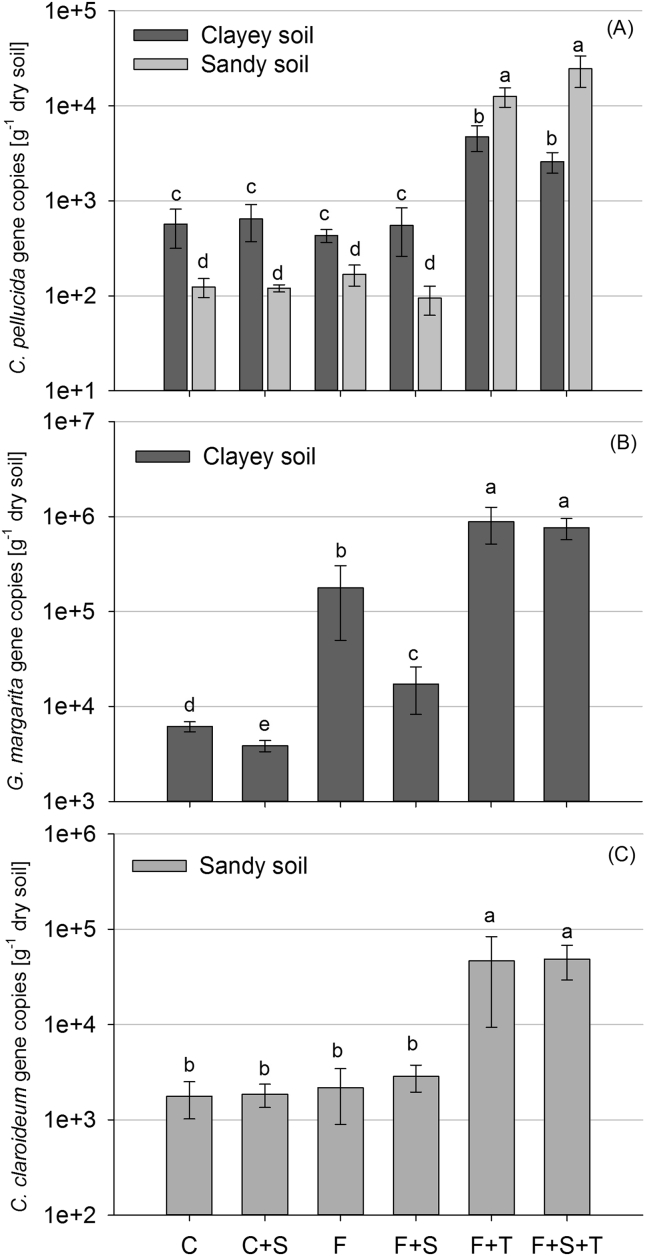
AMF taxa abundance at 42 DAI in the two soils (‘clayey’ (Humic Nitisol), ‘sandy’ (Ferric Alisol)). Different letters indicate significant differences at P < 0.05 and error bars represent standard error. Treatment codes are: uncoated maize (C), uncoated maize with S. hermonthica (C + S), coated maize with ‘Foxy-2’ (F), coated maize with ‘Foxy-2’ and S. hermonthica (F + S), coated maize with ‘Foxy-2’ and T. diversifolia (F + T), and coated maize with ‘Foxy-2’, S. hermonthica and T. diversifolia (F + S + T).